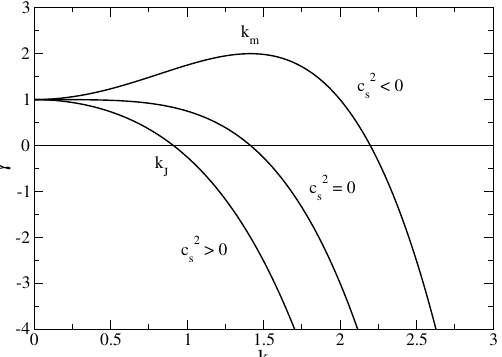
Figure 10. Exponential rate γ for overdamped self-gravitating BECs in the general case. We have normalized the wavenumber by ( 4 π G ρ m 2 /¯ h 2 ) 1/4 , the rate by 4 π G ρ / ξ and the squared speed of sound by ( 4 π G ρ ¯ h 2 / m 2 ) 1/2 . This is equivalent to taking 4 π G = ρ = m = ¯ h = ξ = 1 in the dimensional equations. We have selected c 2 s = 1,0, −